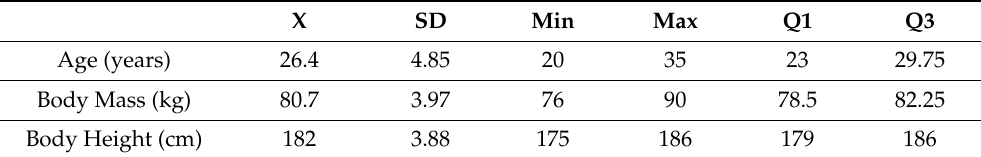
Table 1. Description of the studied group.